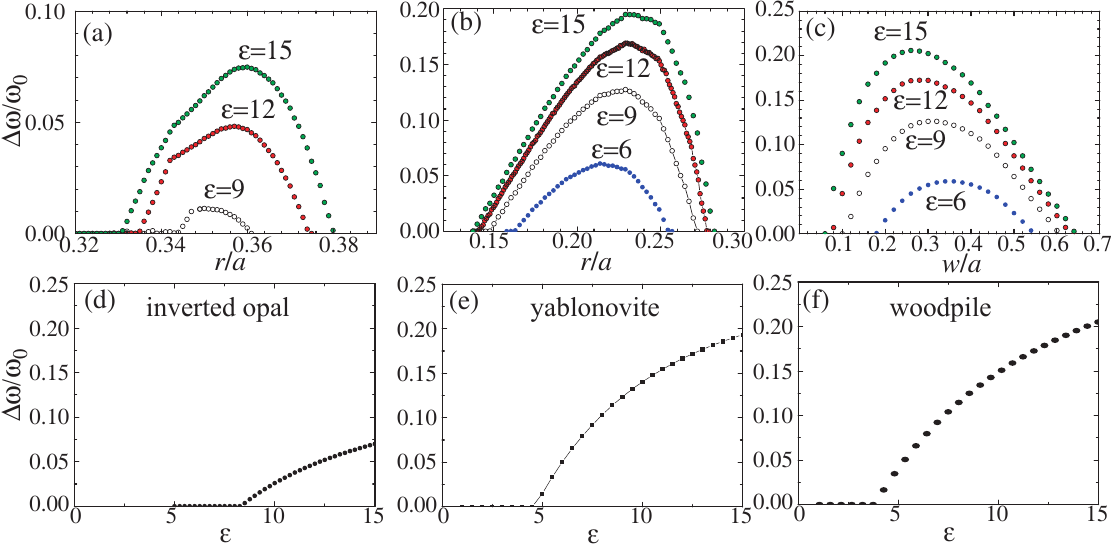
Figure 6. Dependence of the relative complete band gap size ∆ ω/ω of: ( a ) the radius of air spheres in inverted opals; ( b ) the radius of air cylindrical rods in direct yablonovite with w/a = 0 . 23 ; ( c ) the width of square rods in the woodpile; ( d – f ) the dependencies of the complete photonic band gap size ∆ ω/ω relative permittivity ε for inverted opals, direct yablonovite and woodpile. The sphere radius, cylinder radius and rod width are measured in units of the cubic lattice constant a . Reprinted with permission form [7,36], Copyright 2012 and 2014 Pleiades Publishing,